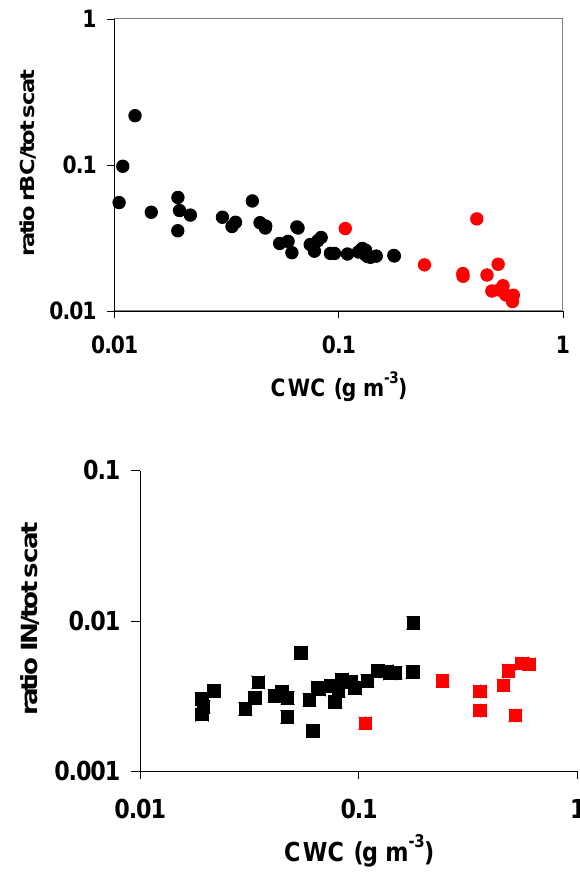
Fig. 11. The ratio of rBC to total particle concentration from the SP2 instrument for the period 05:22 to 05:57 and during the verti- cal profile in Fig. 10 (in red) versus condensed water content (top). The corresponding ratio of IN to total particle concentration versus condensed water content for the period 05:22 to 05:54 (bottom, data not available 05:33–05:35) and for the portion of the vertical profile colder than freezing in Fig. 10 (in red). Data are 60s